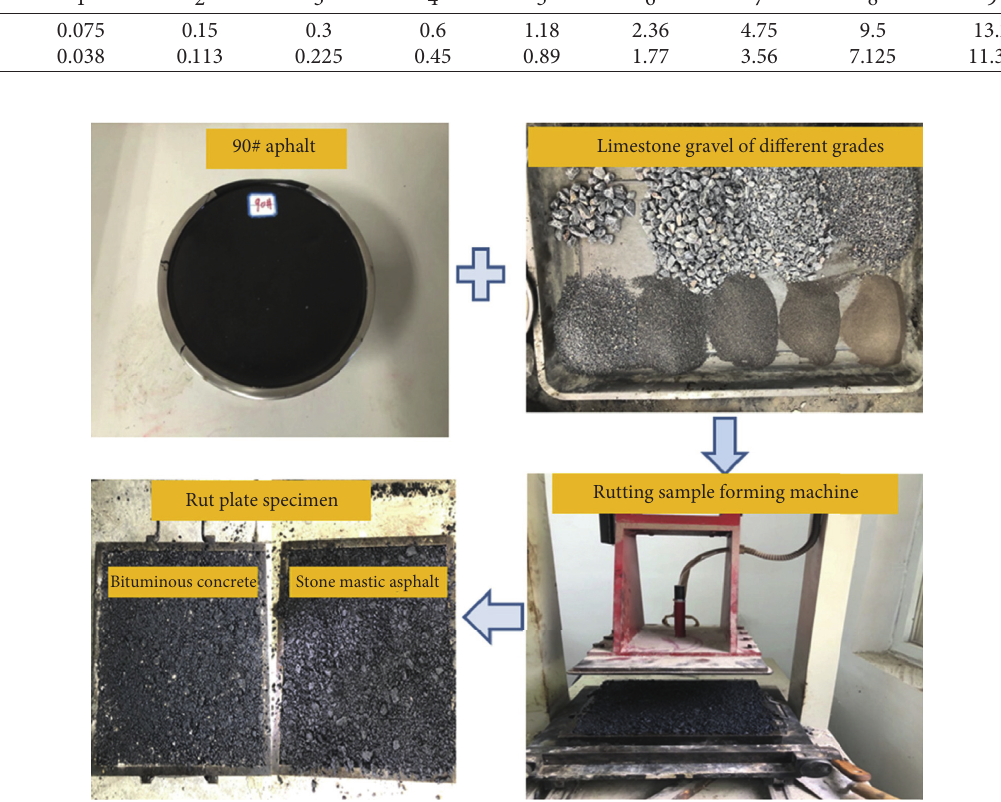
Figure 1: Production process of asphalt mixture.